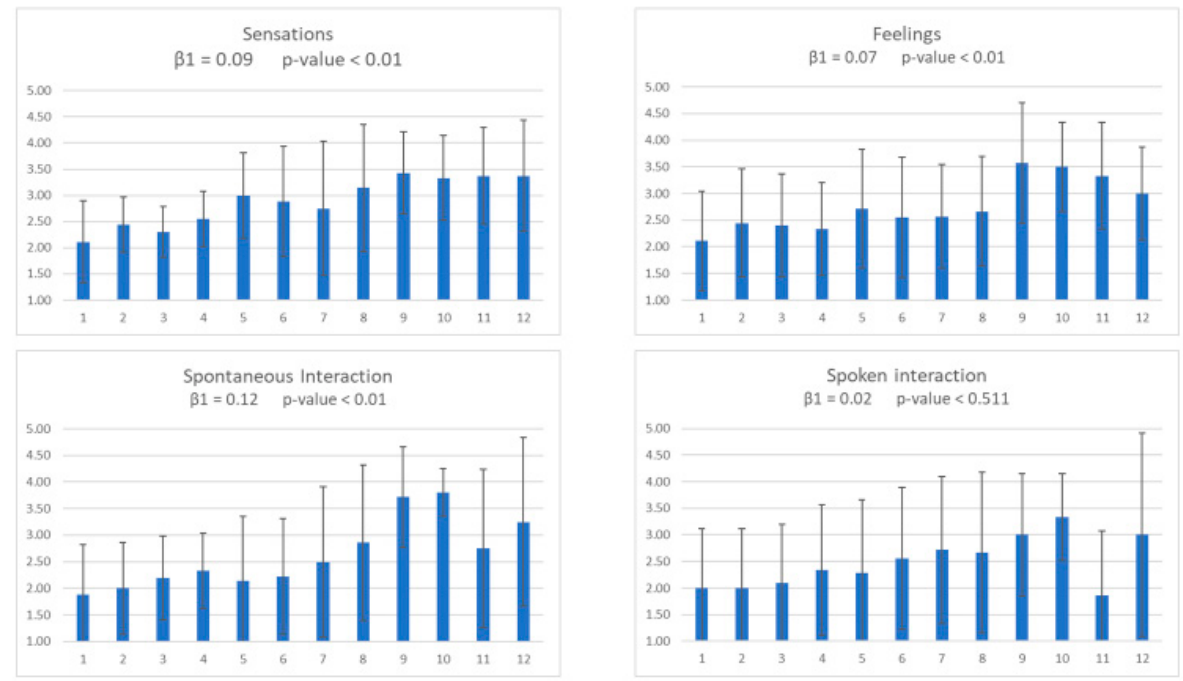
Figure 2. Fortnightly means and SD for the variable “Language and communication,” including expression of sensations, expression of feelings, spontaneous interaction, and spoken interaction. Significant enhancements were observed in all variables but spoken interaction.